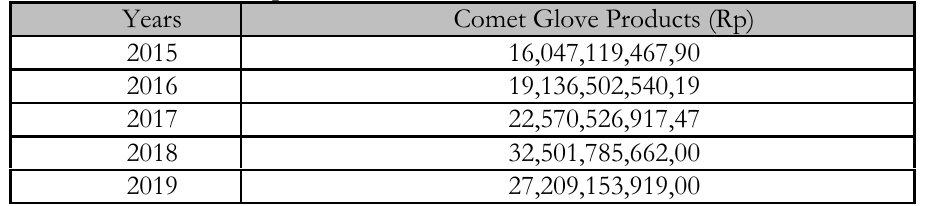
Table 1. Sales Data pt. Alifindo Mitra Bersama Period 2015 –